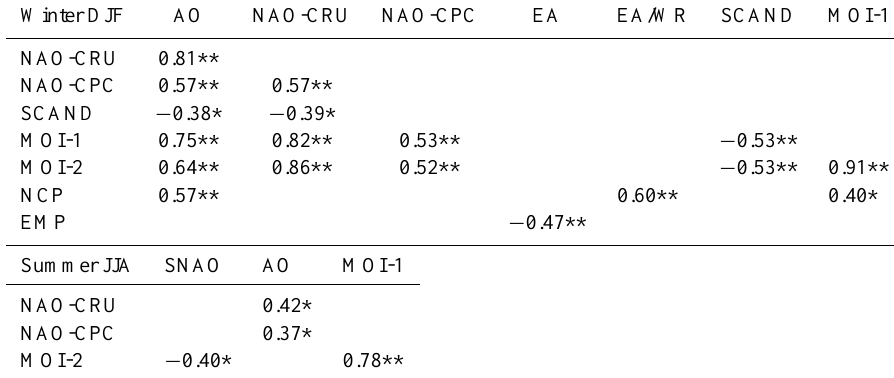
Table 4. Statistically significant correlations for the period 1958–2008 between the circulation